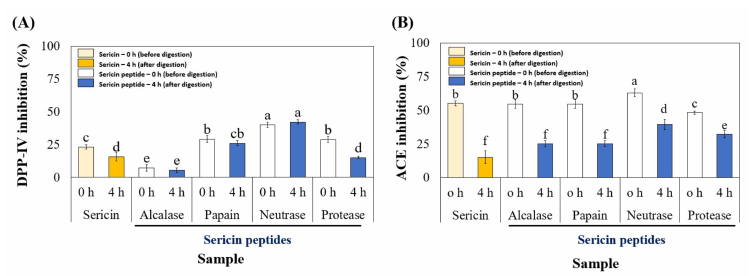
Figure 4. The DPP-IV ( A ) and ACE ( B ) inhibitory activities of sericin hydrolysates before and after 4 h of GI digestion. The DPP-IV and ACE inhibitory activities were measured in the reaction mixture at final concentrations of 2 mg and 0.2 mg Leu. eq./mL, respectively. Significantly different values ( p < 0.05) are represented by superscript letters